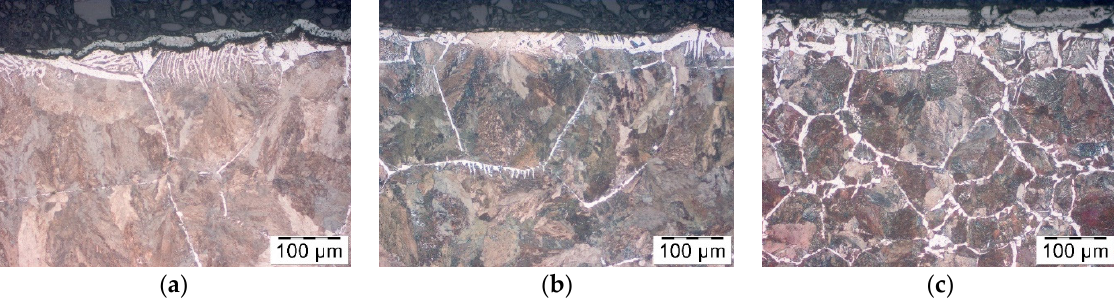
Figure 7. Microstructure of the surface layer of the steel bar C45 after induction heating with Bonderite coating—concentrations ( a ) 100%, ( b ) 66% and ( c ) 50%.